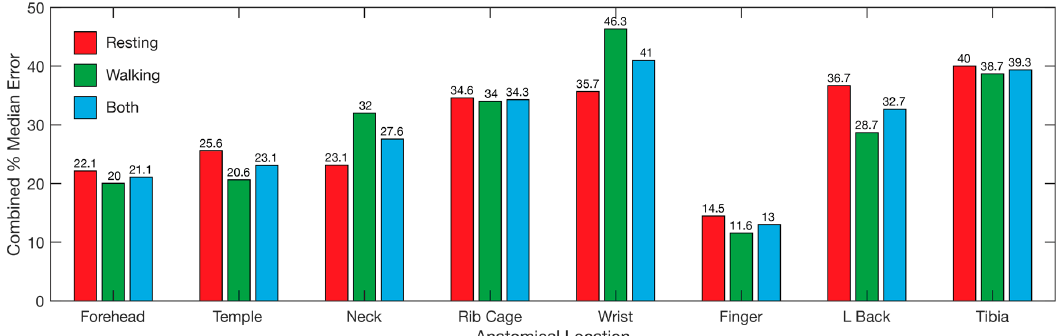
Figure 9. Overall error for each of the tested locations. Bars represent the median error for all three tested parameters, heart rate, SpO 2 , and respiration. Median error for resting (red), walking (blue), and both combined (green) are represented. Wrist refers to the posterior distal forearm. Neck refers to the back of the neck. L back refers to lower back.